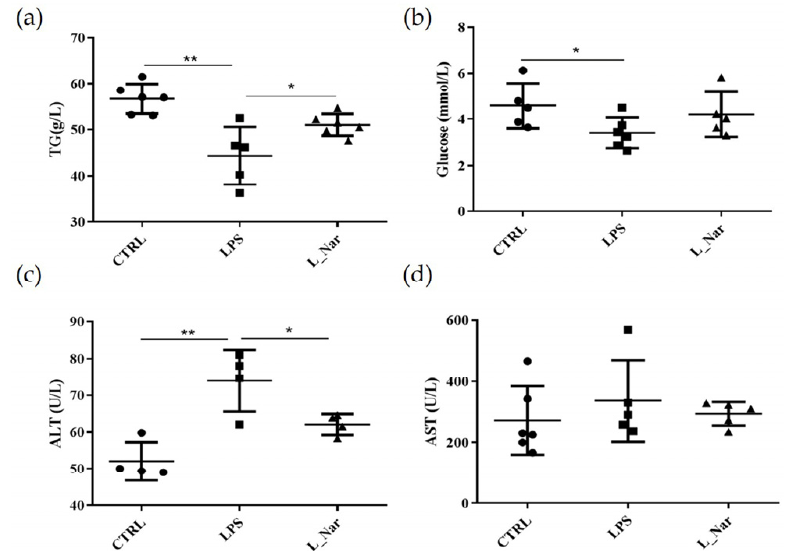
Figure 1. Effects of naringenin on serum parameters of LPS ‐ induced mice: ( a ) serum TG; ( b ) serum glucose; ( c ) ALT; ( d ) AST levels. Data are mean ± SEM. * p < 0.05, ** p < 0.01 versus CTRL group, LPS group or L_Nar (LPS+Nar) group; TG: triglyceride; ALT: alanine aminotransferase; AST: aspartate aminotransferase.